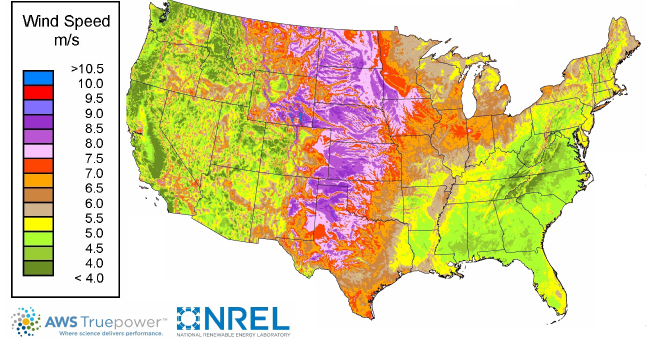
Figure 2. Wind Map of the U.S.: annual average wind speed at 80 m, published by National Renewable Energy Laboratory (NREL)